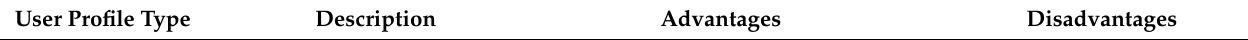
Table 1. A comparative table of user profile types, in relation to the researched